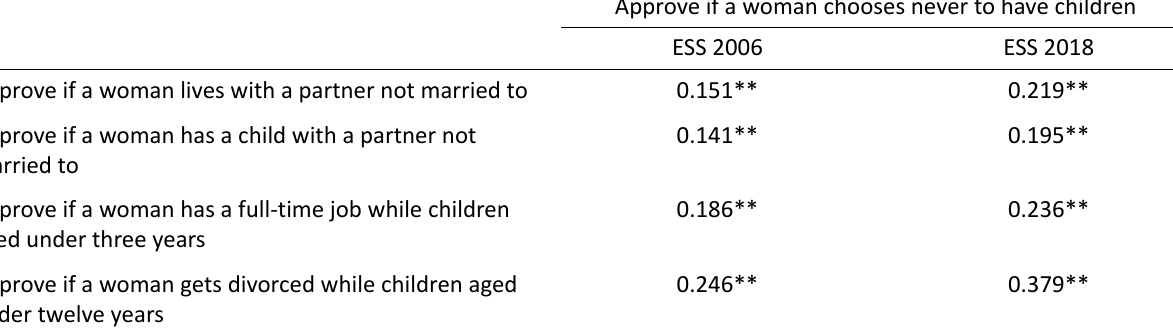
Table 2. Pearson correlations of attitudes toward female voluntary childlessness, parenthood, marriage, and divorce in